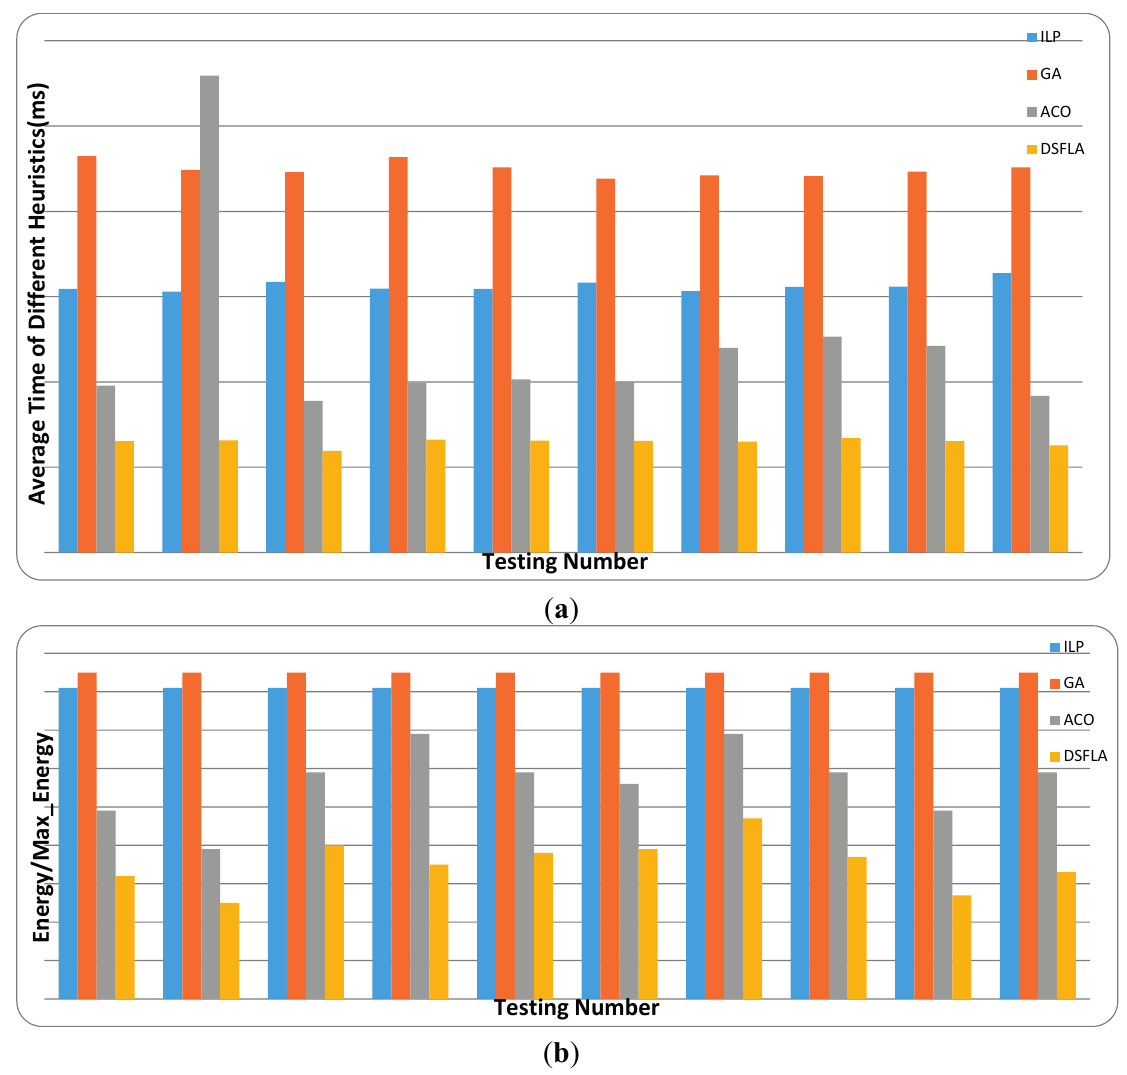
Figure 11. The average runtime and energy consumption of real data set 2 for different heuristics: ( a ) average time and ( b ) energy